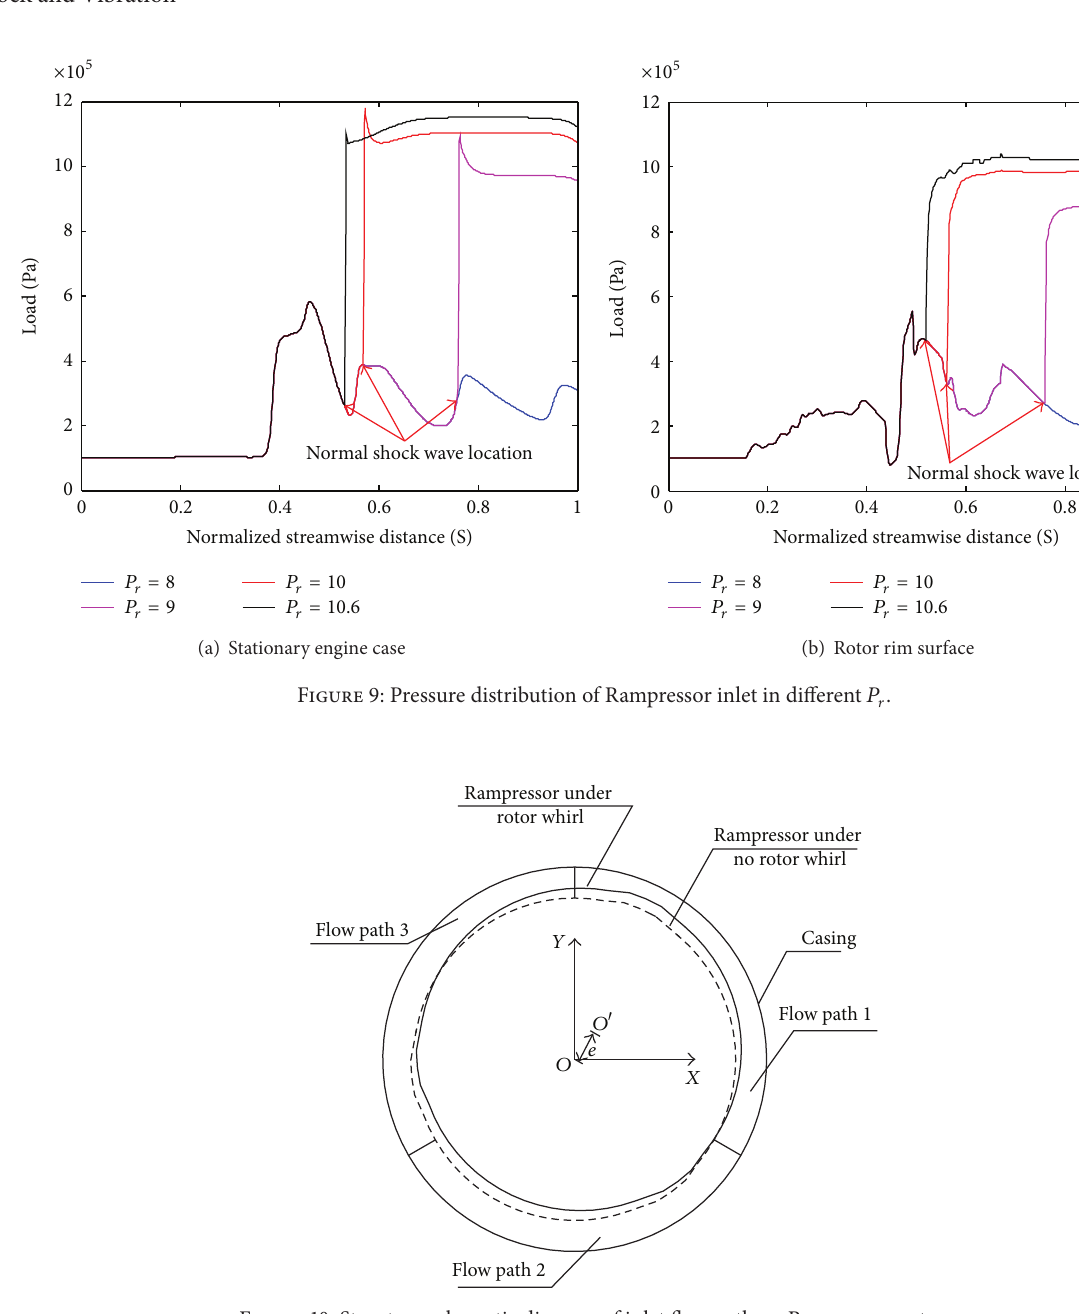
Figure 10: Structure schematic diagram of inlet flow path on Rampressor